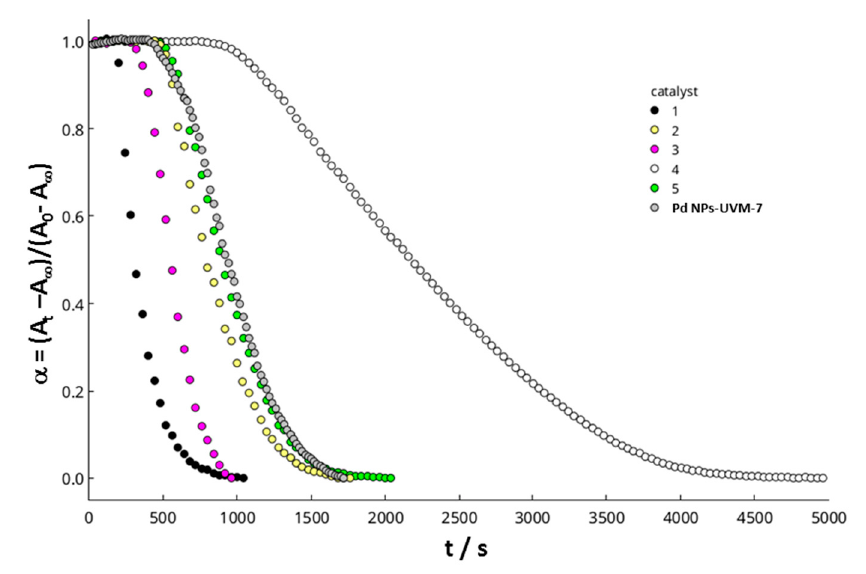
Figure 7. α (t) values calculated from absorbance at 402 nm during the reduction at room temperature of 4-nitrophenolate with (Et 4 N)BH 4 catalyzed by materials Pd NPs-UVM-7 / PDA- n ( n = 1 to 5 ) and Pd NPs-UVM- 7 ; [NO 2 PhO − ] = 5.02 × 10 − 5 M; [(Et 4 N)BH 4 ] = 2.0 × 10 − 2 M; [Pd] = 6.3 × 10 − 8 M. Reaction medium: acetonitrile: water 1:1 v/v.